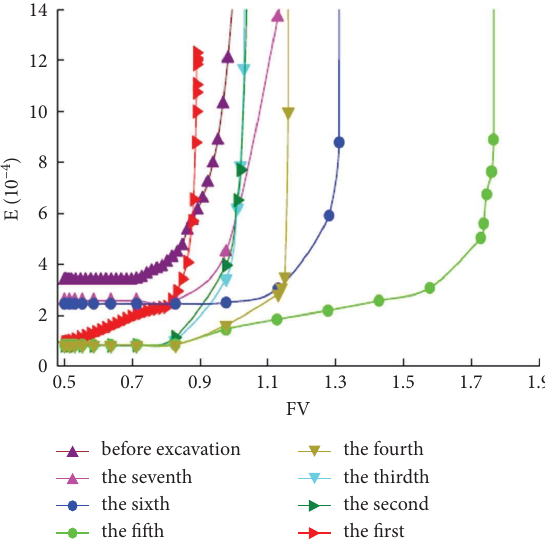
Figure 15: Strain curve during